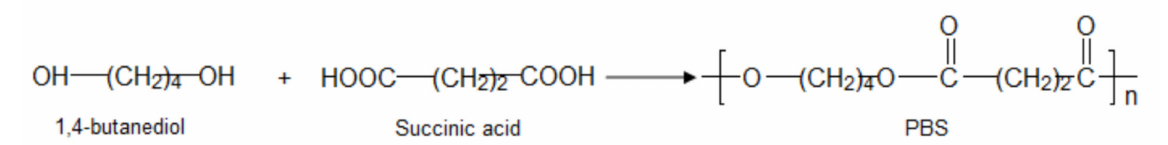
Figure 3. Synthesis of PBS [43]. Adapted with permission from Yu et al. (2011).